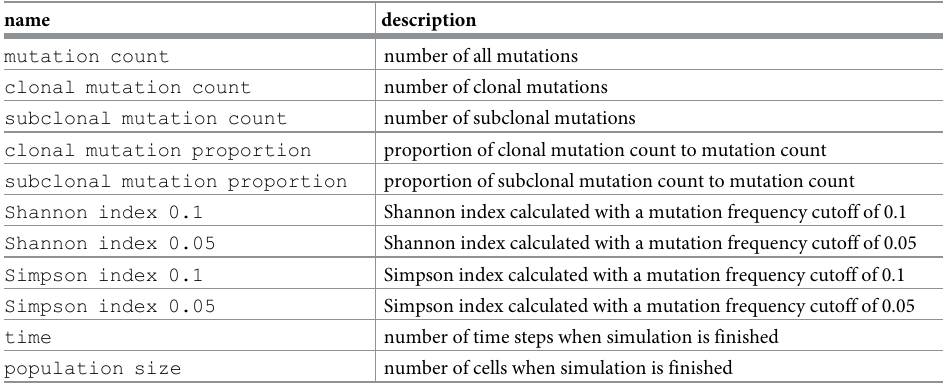
Table 3. Summary